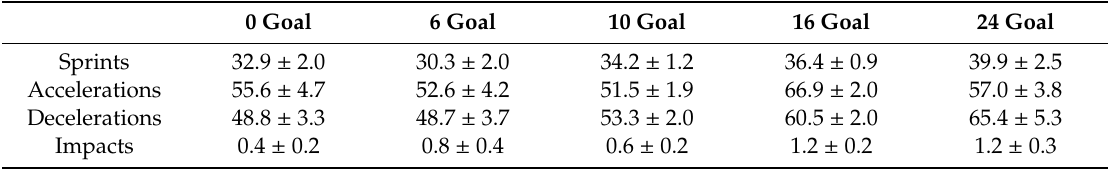
Table 3. High-intensity activities per chukka at each level of play. Data are presented as means ± 90% confidence